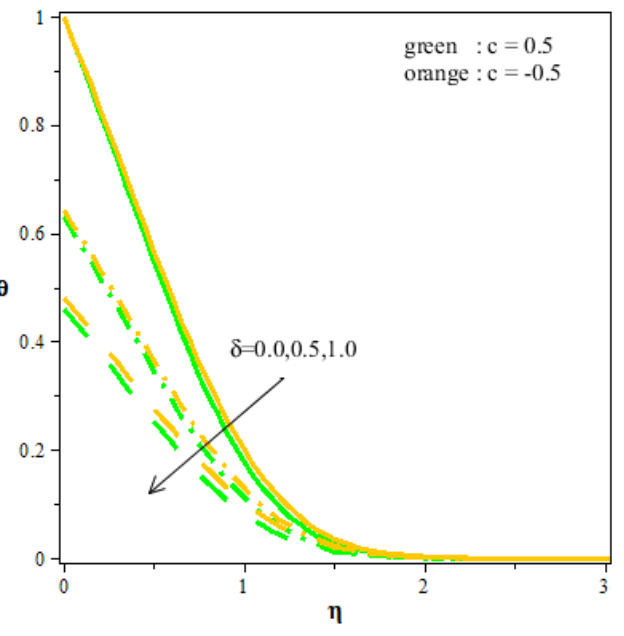
Figure 12. The curve ( ) on .